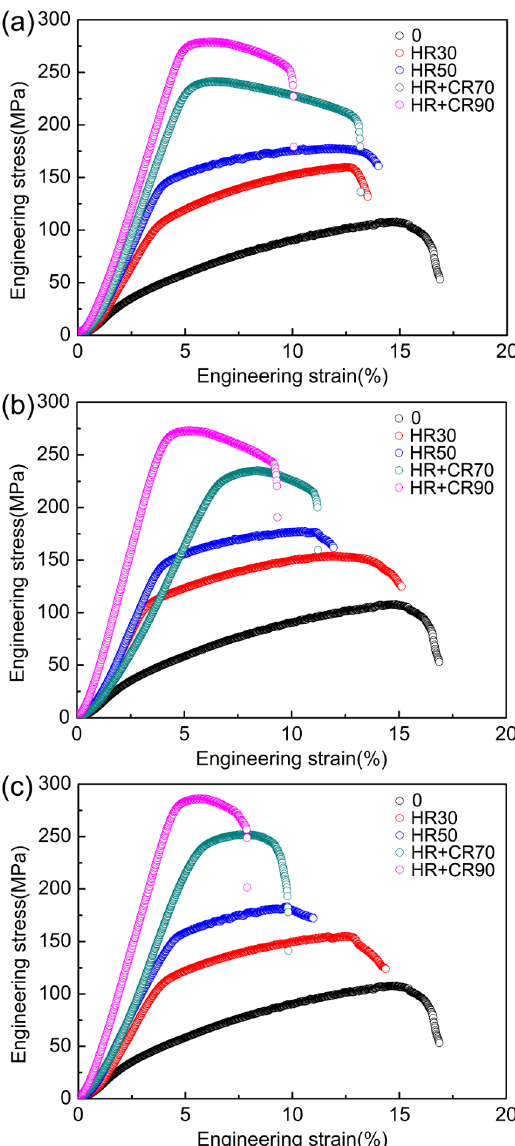
Figure 2. Engineering stress-engineering strain curves along three directions of (a) 0º, (b) 45º, (c) 90º with different rolling deformation.